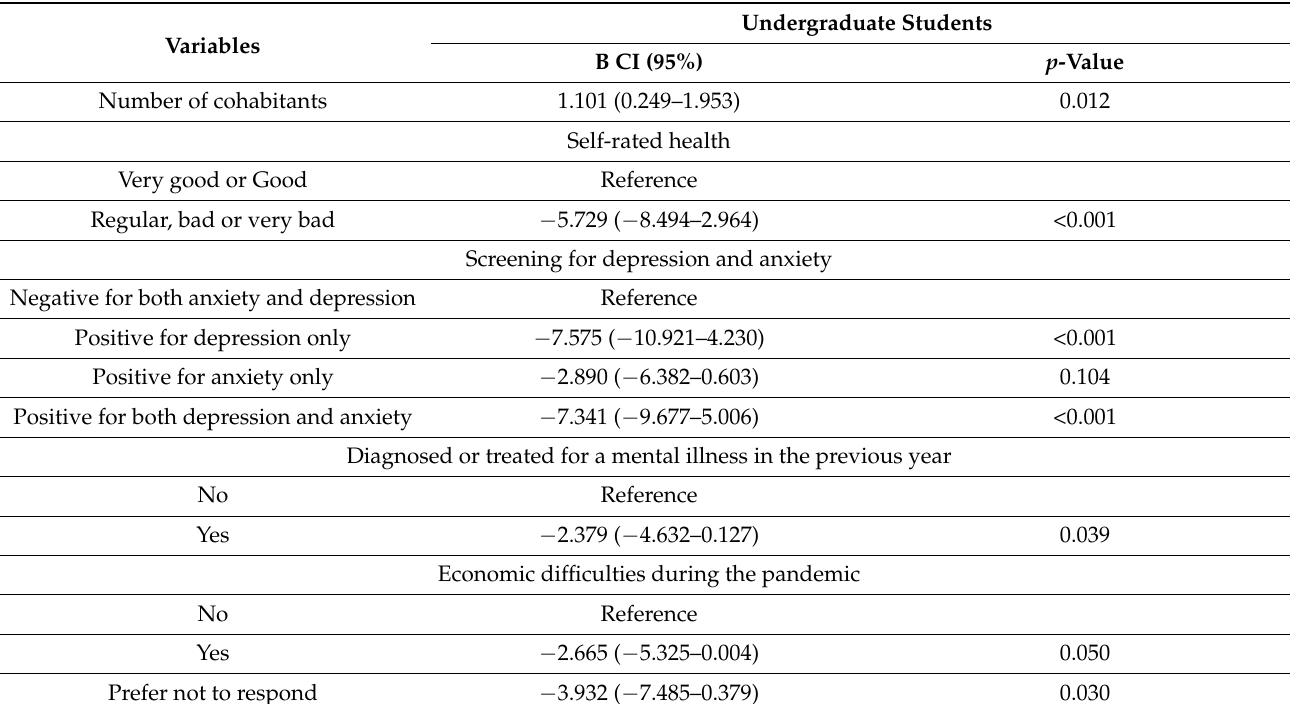
Table 5. Factors associated with better SMILE-C score among the undergraduate students